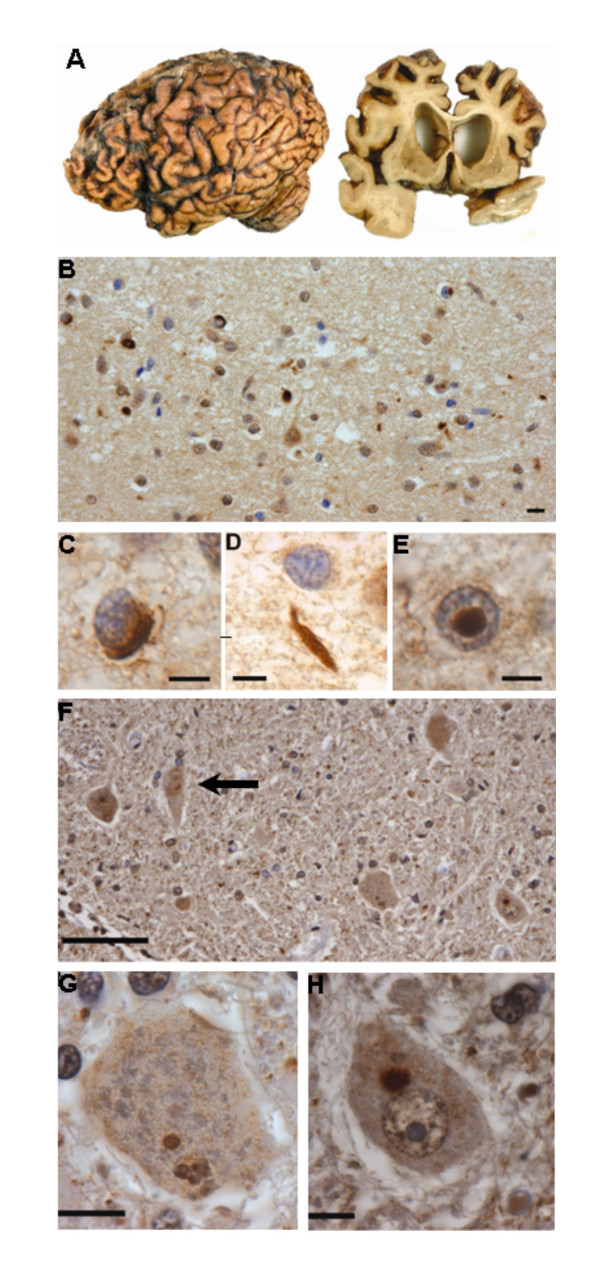
(A) On the left, hemi-brain from individual III-1 of family 476 diagnosed with FTD showing marked frontal and anterior temporal lobe atrophy. On the right, a coronal slice showing severely dilated lateral ventricles with narrowed gyri and widened sulci; (B) ubiquitin-positive, tau-negative inclusions in the superficial laminae of the middle frontal gyrus (arrow, scale bar = 10 nm); (C) high power photomicrograph of a neuronal cytoplasmic inclusion; (D) high power photomicrograph of a dystrophic neurite in the neuropil; (E) high power photomicrograph of a neuronal intranuclear inclusion (C -E, bar = 5 nm); (F) Ubiquitin-positive cytoplasmic inclusions in motor neurons of the lower medulla-spinal cord (arrow, bar = 50 nm); (G) higher power photomicrograph of a neuron containing a cluster of Bunina body-like inclusions; (H) higher power photomicrograph of a loosely aggregated cytoplasmic inclusion (G & H, ubiquitin immunohistocemistry, bar = 5 nm).